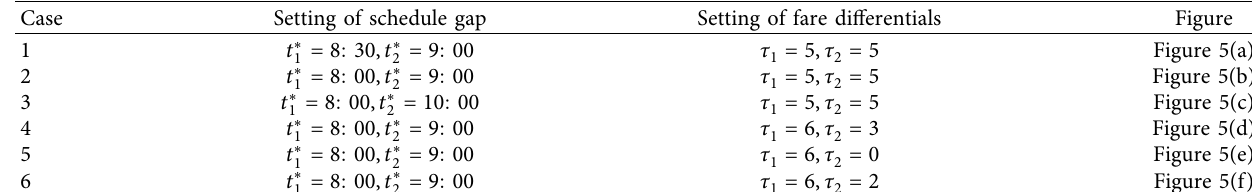
Table 2: The setting of schedule gap/fare differentials during rush and flat hours. Case Setting of schedule gap Setting of fare